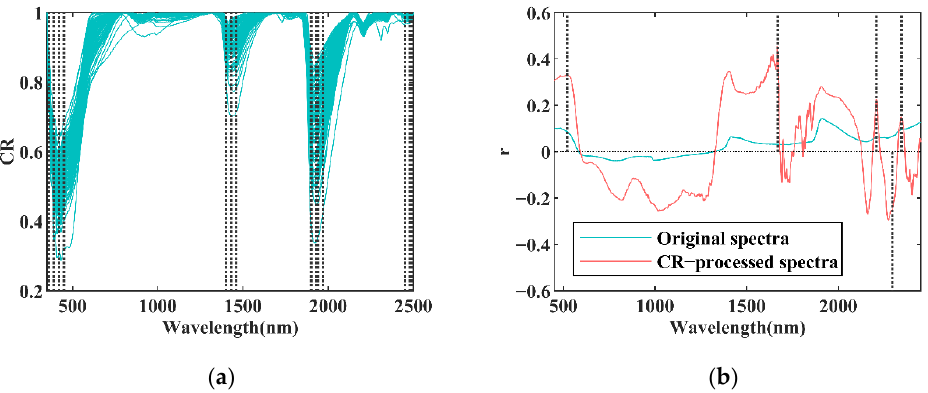
Figure 3. ( a ) Continuum removed spectra (dot lines represent the ignored bands); ( b ) The correlation coefficient between Pb and raw reflectance and continuum removed reflectance (dot lines are the sensitive bands of the optimized model selected). Table 2. The range of sensitive bands based on Pearson correlation with Pb. CSF 1 /k